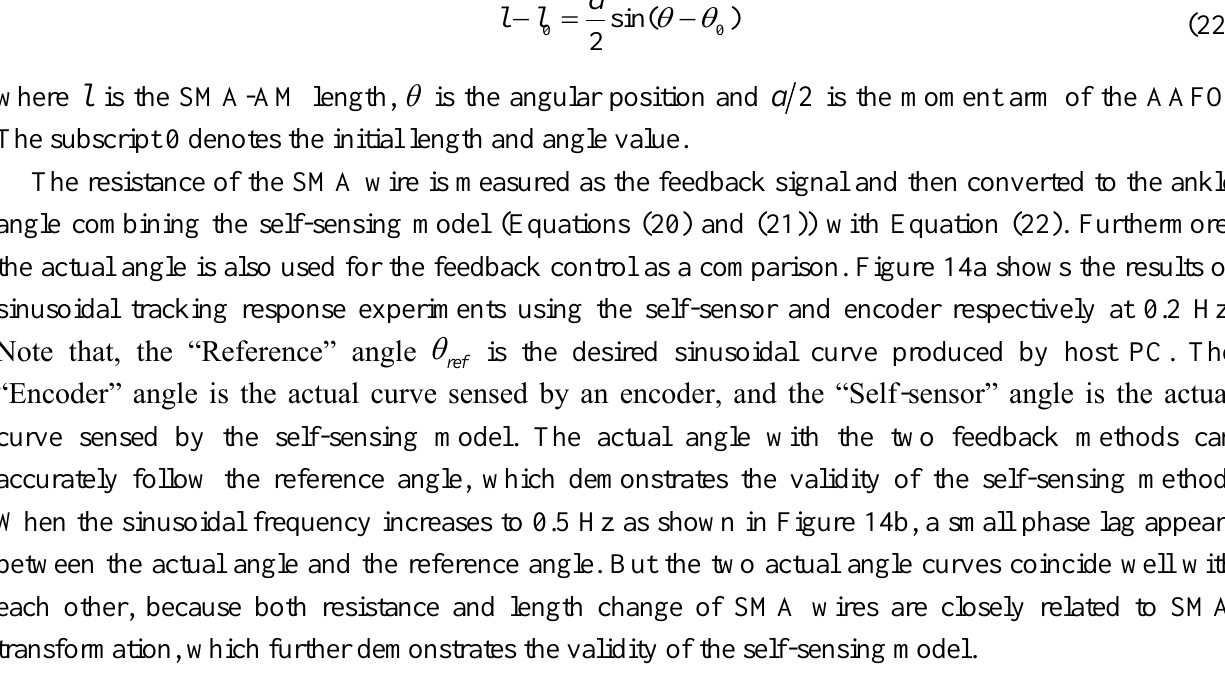
Figure 14. Sinusoidal tracking response at 0.2 Hz ( a ) and 0.5 Hz ( b